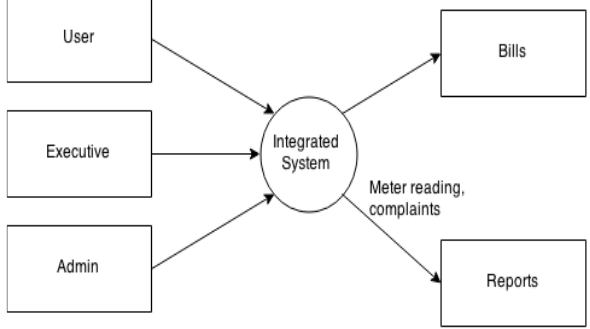
Figure 8. Level Zero DFD for the